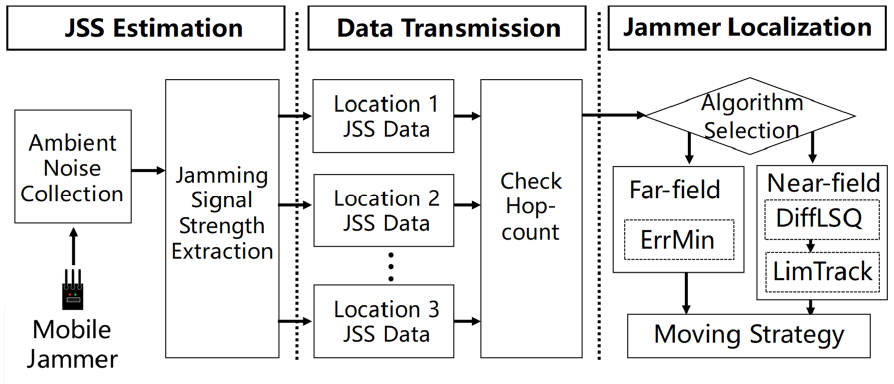
Figure 2. Workflow of JamCatcher. JSS, jamming signal strength; ErrMin, error